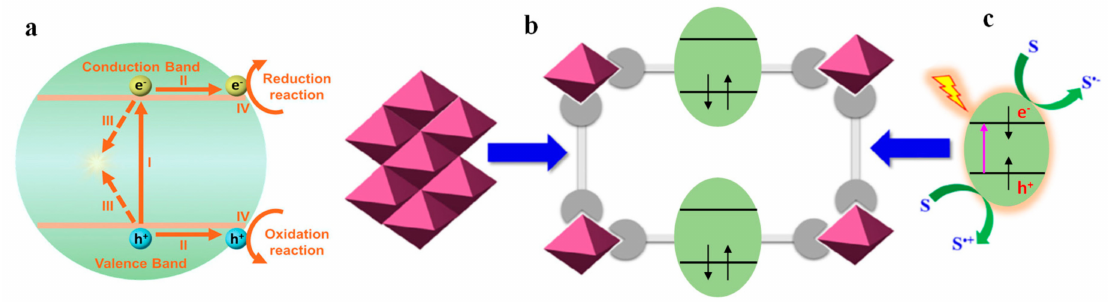
Figure 1. Schematic illustration of the elementary steps of a photocatalytic process involving an inorganic semiconductor photocatalyst ( a ) or an organic molecule ( c ). Also, a schematization of the combination between the fundamental units of semiconductor-like nodes and dye moiety containing bridging ligands in photocatalytic hybrid materials ( b ). Reprinted with permission from [1], Copyright (2019)